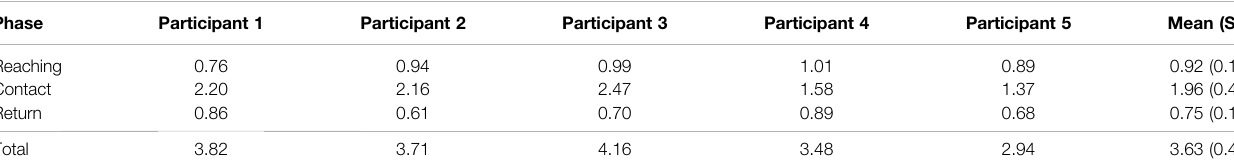
TABLE 3 | Duration of the phases of the handshake (in sec). Phase Participant 1 Participant 2 Participant 3 Participant 4 Participant 5 Mean (SD) Reaching